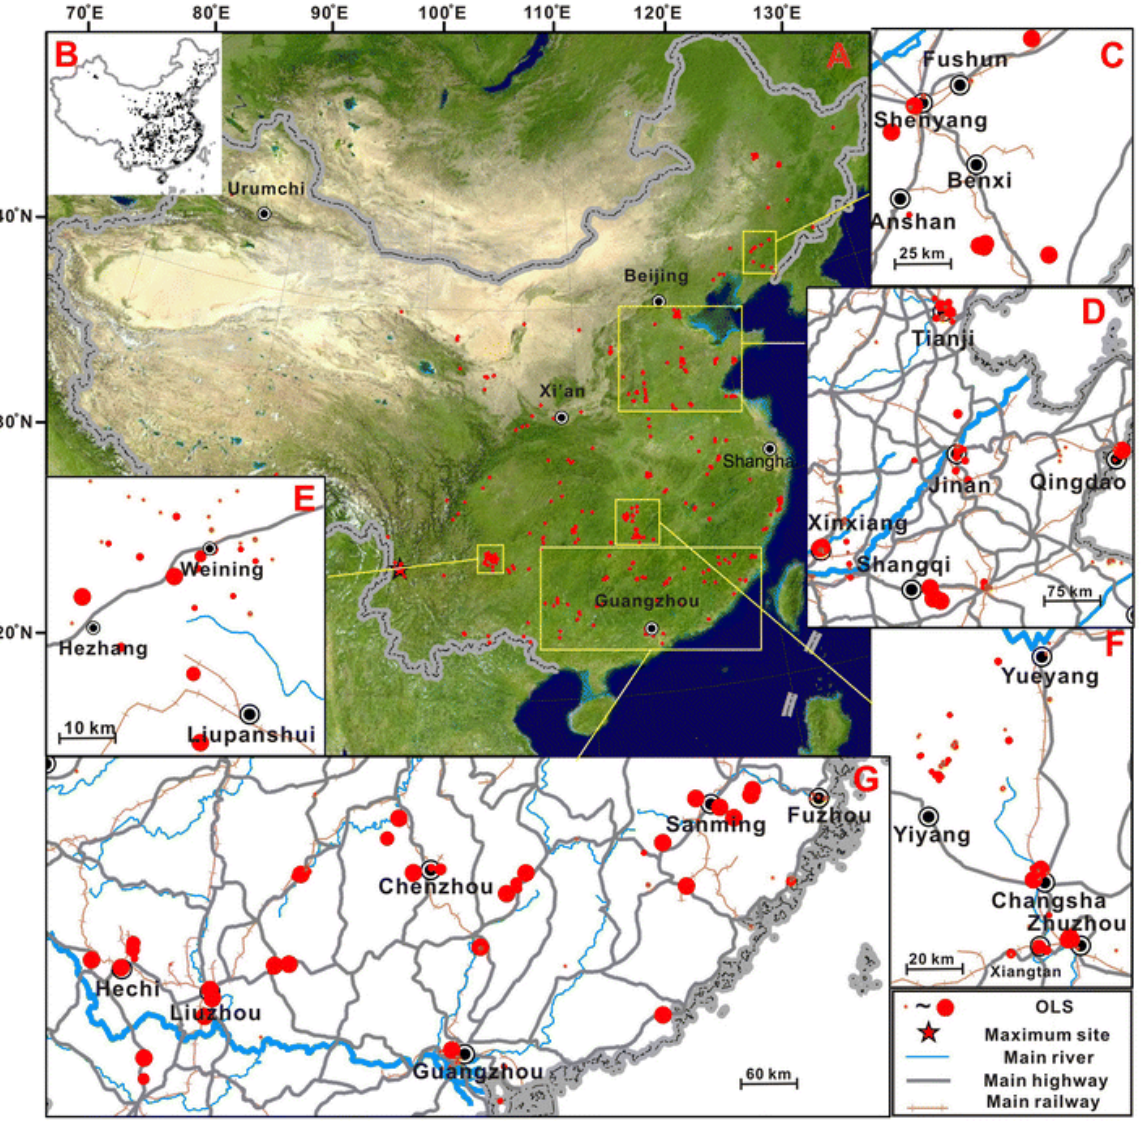
Fig. 1. China’s distribution of cadmium Over Limit Sites (OLSs) (A); Distribution of cadmium sampling sites (B-G) (Source: Duan et al., 2016) Note: In (C) (D) (E) (F) and (G), Over Limit Sites (OLSs, red dots) were grouped into 4 classes: 1–3, 3–5, 5–10, and >10 according to the multiples of the limit value (Cd: 1